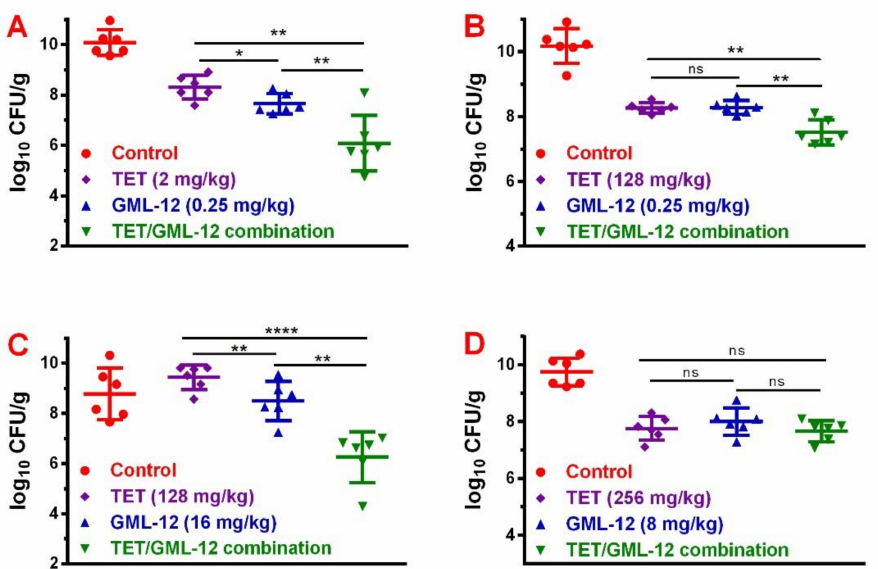
Figure 3. Therapeutic e ff ect of TET and GML-12 alone and in combination against ATCC 43,765 ( A ), S40 ( B ), SNJ-5 ( C ) and S11 ( D ) in neutropenic mice. The bacterial load of infected thigh muscle in neutropenic mice ( n = 6 per group) was determined by colony counting. All data are mean ± s.d. p values were determined using an unpaired, two-tailed Student’s t-test. ns, p > 0.05; *, p < 0.05; **, p < 0.01; ***, p < 0.001; ****, p <